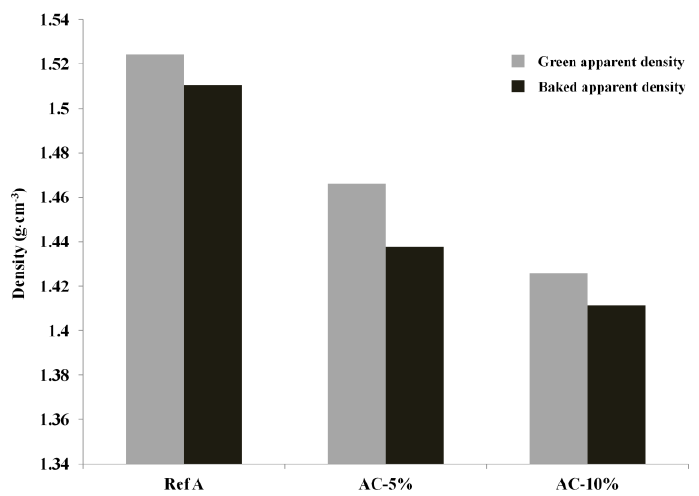
Figure 1. Apparent density for green and baked anodes with different amounts of charcoal.